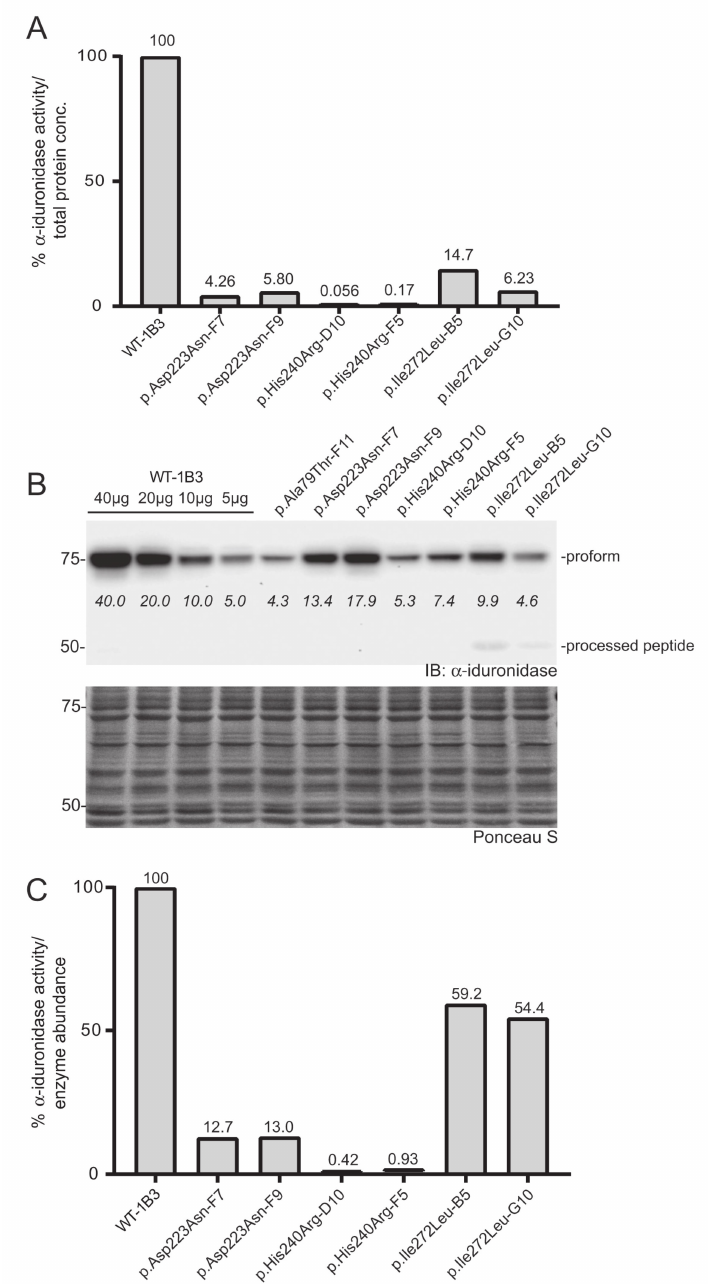
Figure 4. Determination of the relative specific activity in WT and variant IDUA -expressing cell clones. ( A ) Relative α -iduronidase activity in cell lysates from di ff erent single cell clones. ( B ) Representative Western blot for α -iduronidase in the cell lysates from these clones. Ponceau S staining was used to confirm equivalent total protein loading. ( C ) Relative specific activity determination in the clones calculated by dividing relative enzyme activity by relative α -iduronidase abundance as measured by